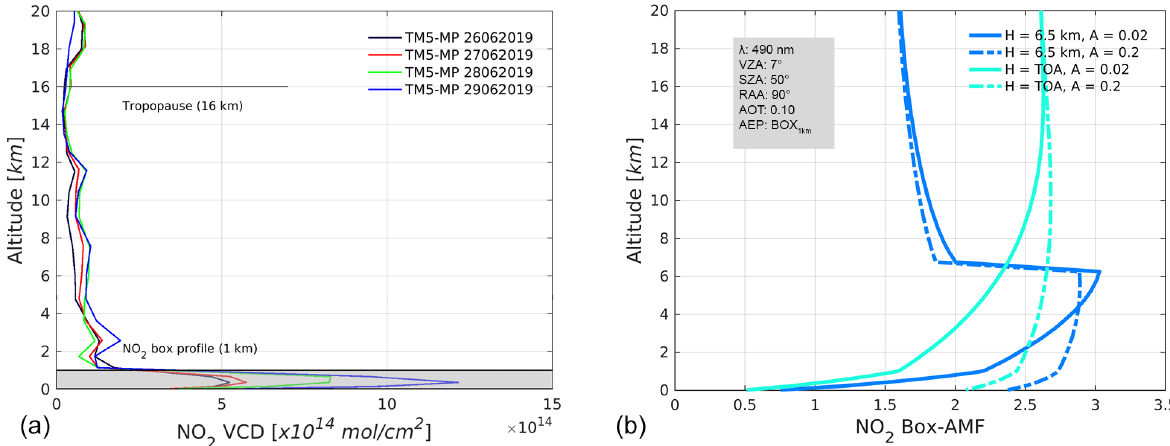
Figure 3. (a) Representation of a well-mixed NO 2 box profile of 1km thickness and TM5-MP NO 2 profiles interpolated over the campaign sites for Flight nos. 1–4, and (b) height-dependent box AMFs representing the vertical sensitivity to NO 2 , illustrated for APEX, operating at 6.5kma . g . l . , and TROPOMI, for both a low and high surface reflectance